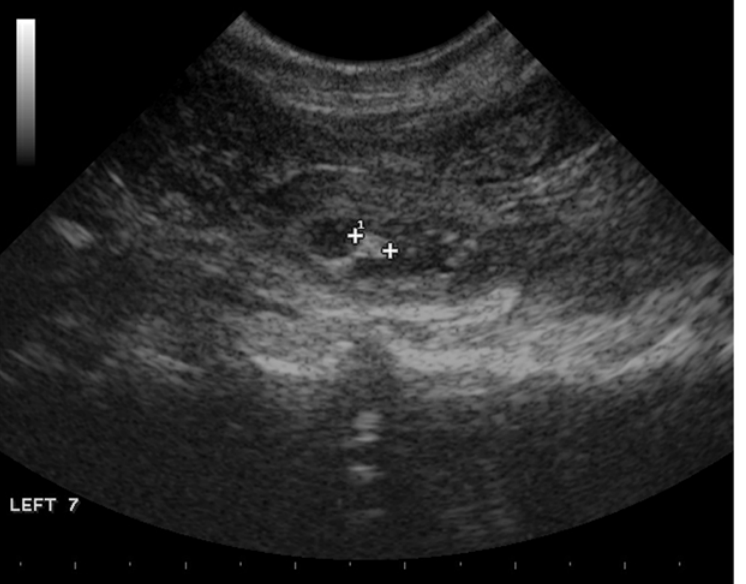
Figure 1. Ultrasound image showing an egg in the uterus of echidna 5D5E on July 23 2008. Fertilization probably occurred on July 9, but she had fresh sperm in her reproductive tract and was also torpid. Distance between the two markers showing the structure within the egg is 0.35 cm.